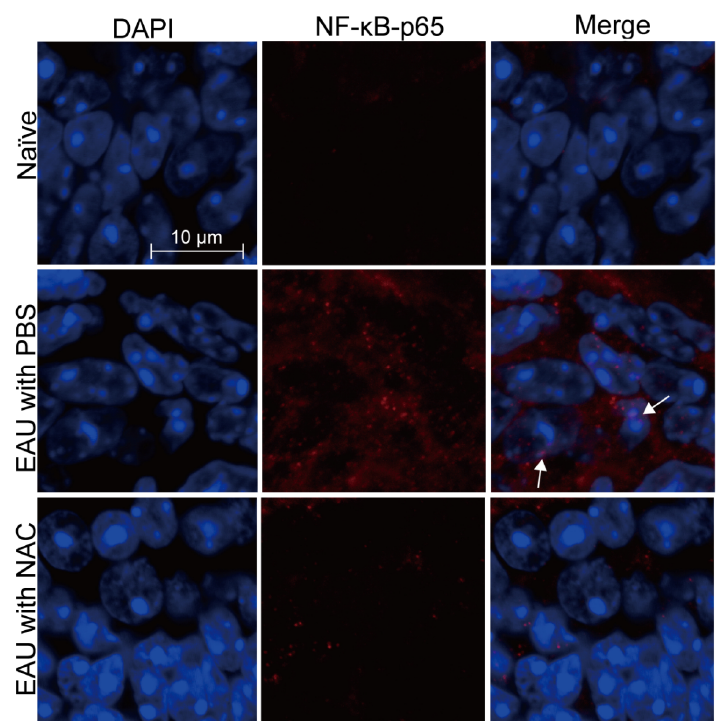
Figure 7. NAC treatment reduces NF- κ B activation in the retinas of mice with EAU induction. Eyes and retinas of wild-type mice without EAU induction (naïve) or with EAU induction and treated with PBS or NAC were subjected to immunofluorescence staining for nuclei with DAPI and for NF- κ B (p65) with antibody. The outer nuclear layer of the retina is shown. Images are representative of at least four samples per group from two independent experiments. Arrows indicate NF- κ B in the nucleus.